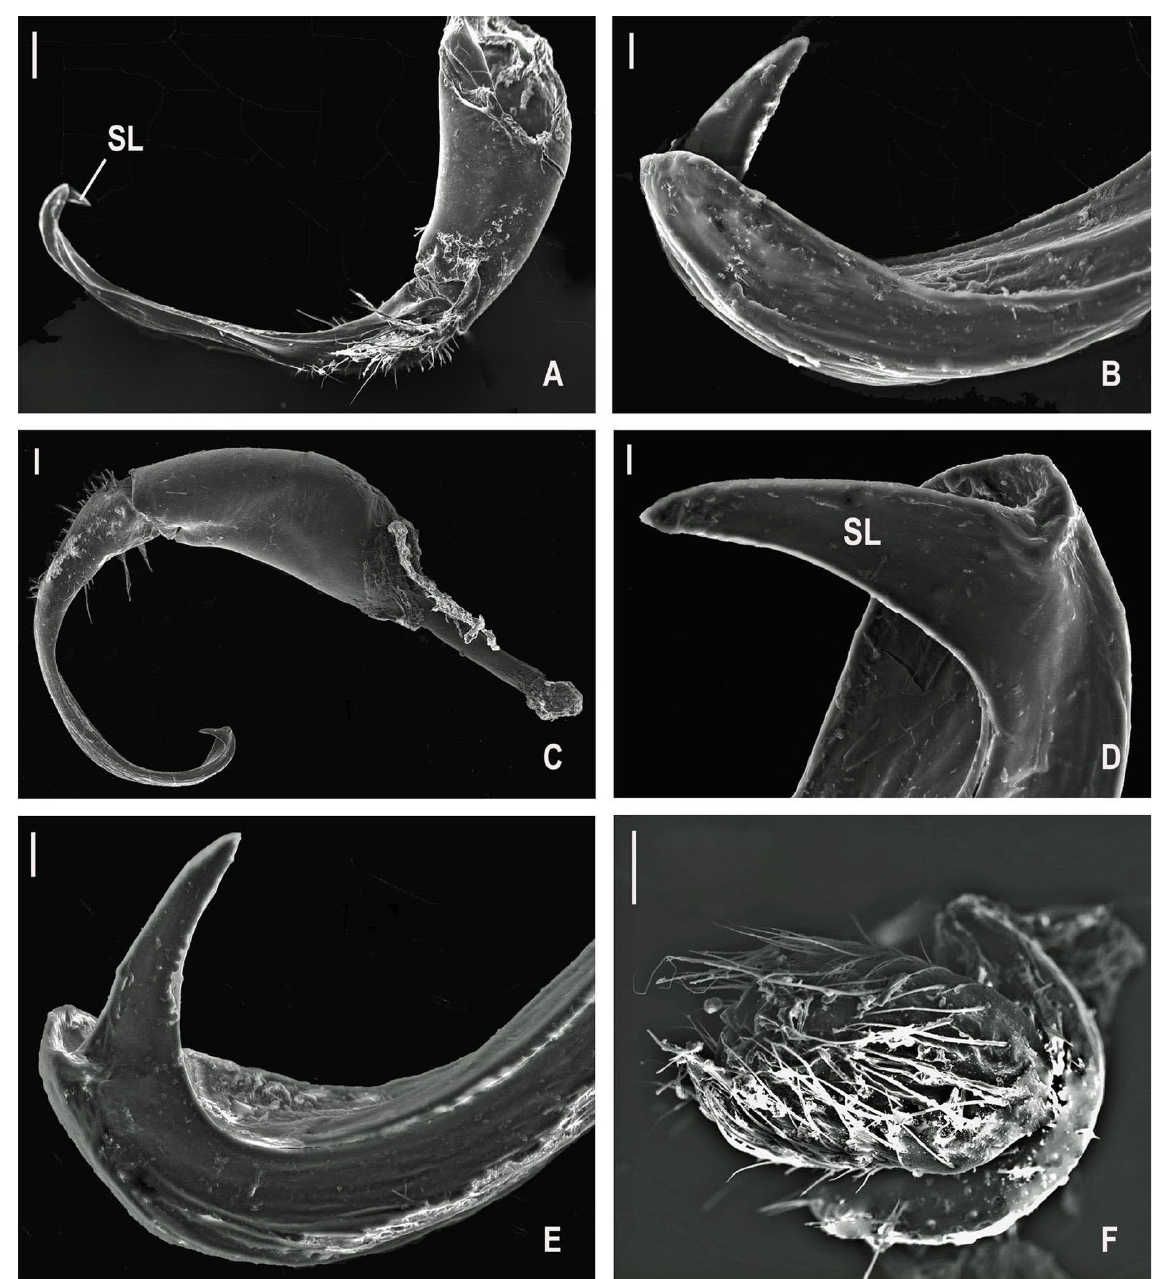
Fig. 5. Levizonus laqueatus Mikhaljova, 1981, ♂, ♀ (FSCB 101979). A . Gonopod, mesal view. B . Gonopod apex, mesal view. C . Gonopod, lateral view. D . Gonopod apex, lateral view. E . Gonopod apex, ventral view, slightly turned mesally. F . Vulva, ventromesal view. Scale bars: A = 200 μm; C, F = 100 μm; B, E = 20 μm; D = 10